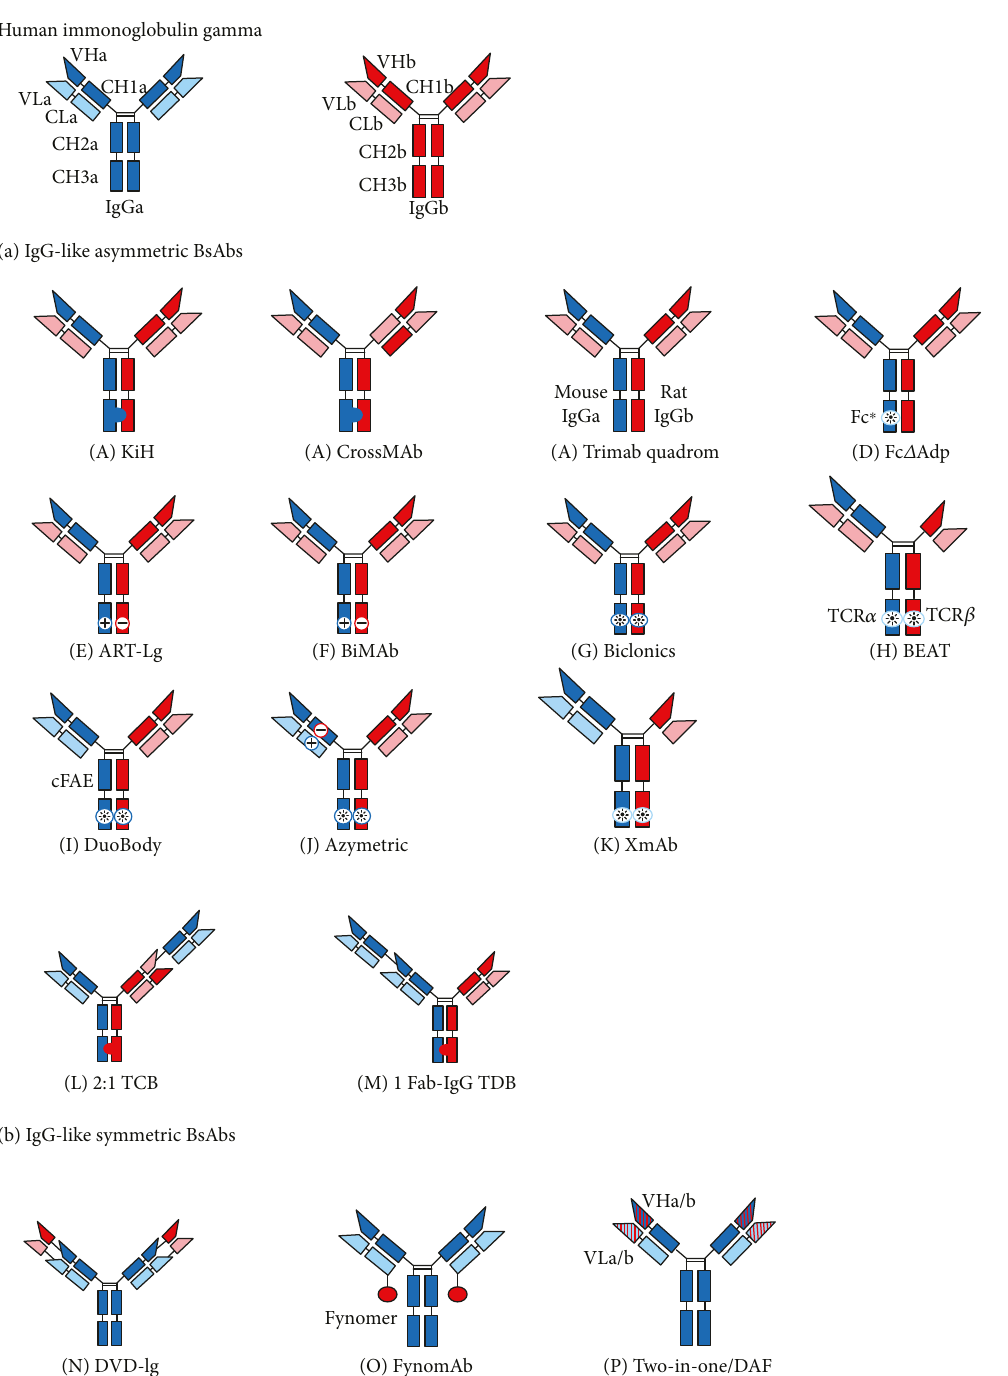
Figure 1: The upper line depicts human immunoglobulin gamma (IgG) parental antibodies IgGa and IgGb. (a) IgG-like asymmetric BsAb platforms including the following: (A) KiH, (B) CrossMAb, (C) Triomab quadroma, (D) Fc Δ Adp, (E) ART-Ig, (F) BiMAb, (G) Biclonics, (H) BEAT, (I) DuoBody, (J) Azymetric, (K) XmAb, (L) 2 :1 TCBs, and (M) 1Fab-IgG TDB; (b) IgG-like symmetric BsAb platforms including the following: (N) DVD-Ig, (O) FynomAb, and (P)